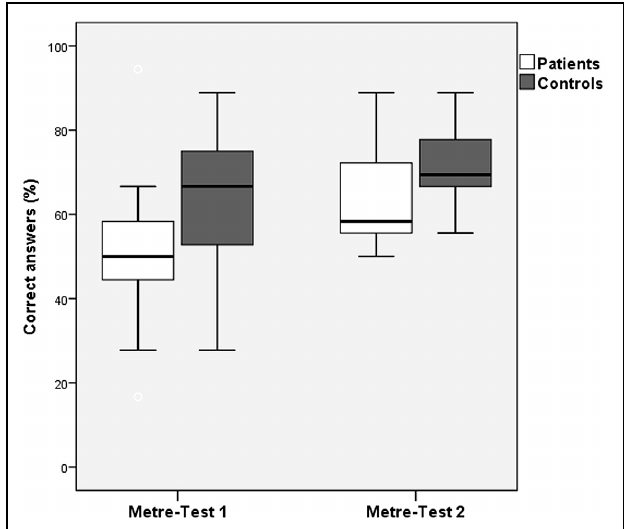
FIGURE 3 | Correct answers (mean values) of left- and right-sided stroke patients for Melody Interval Test vs. Rhythm Test (error bars indicate one standard deviation).